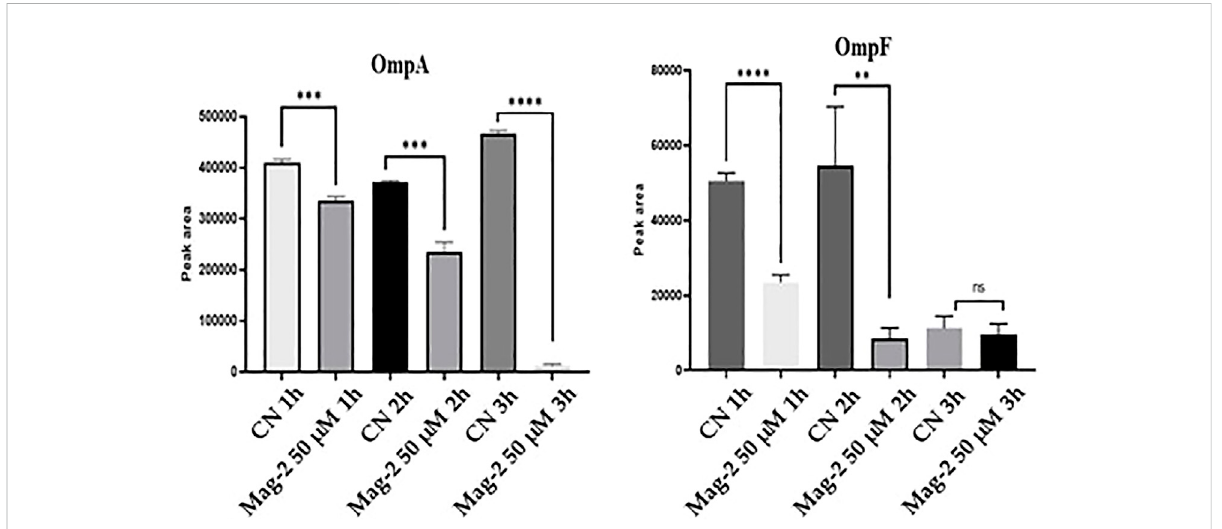
FIGURE 8 QuantitativemeasurementsofOmpAandOmpFproteinsatdifferenttimesofincubationof E.coli cellswithMag-2basedonMRM/MSanalyses. Statistical signi fi cance, p -value < 0.05, was indicated as * in the fi